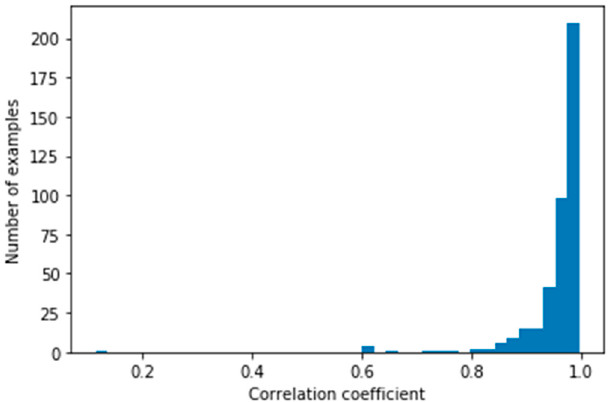
Figure 12. Histogram of correlation per subject.